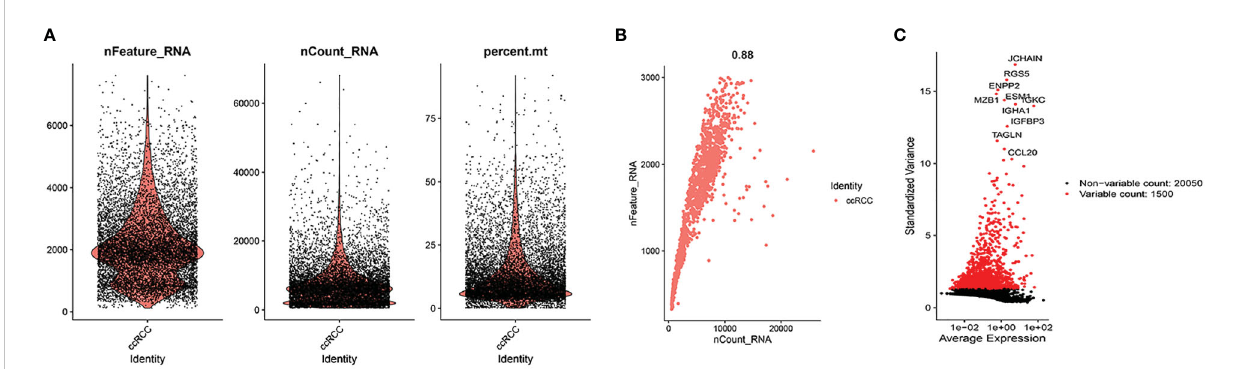
FIGURE 2 Quality control. (A) When gene expression levels in cells of ccRCC samples were in the range of 300-3000, the distribution of each cell was relatively even. At the same time, we also found the mitochondrial genes of the majority of cells were <5%. (B) The cells were uniformly distributed in the ccRCC samples and the gene expression levels were positively associated with the amount of gene expression (0.88). (C) 10 hypervariable genes.